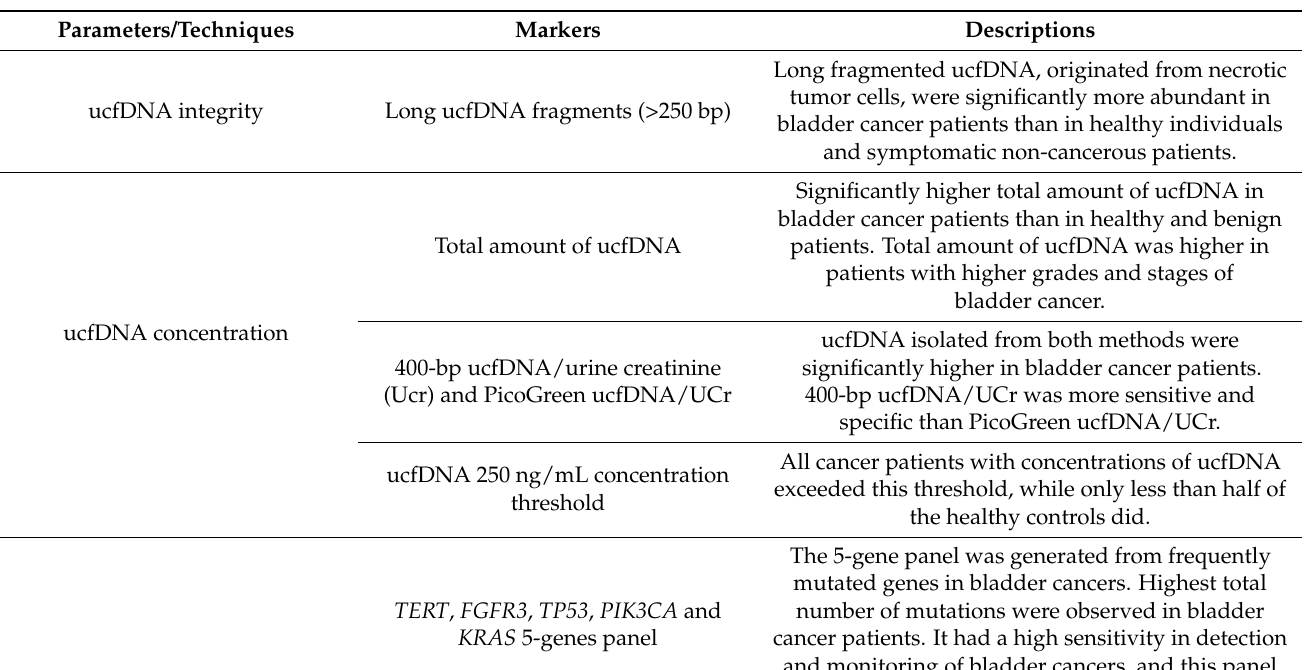
Table 1. Summary of different parameters and techniques and potential markers in urinary cell-free DNA (ucfDNA) for bladder cancer detection, monitoring, and